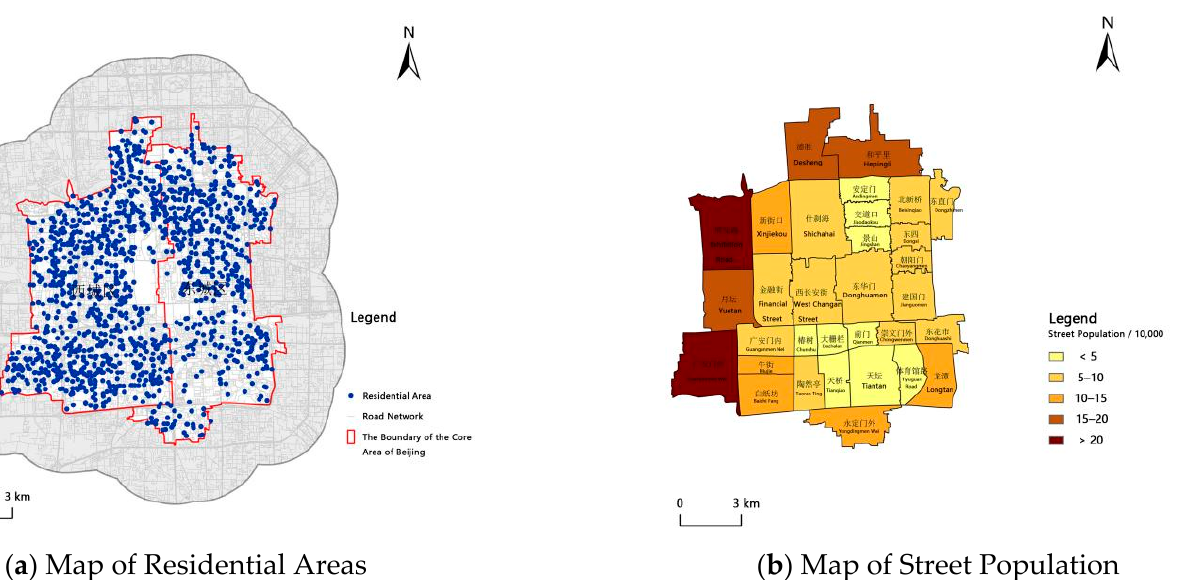
Figure 3. Map of residential areas and street population ( a ) showing the distribution of residential areas in the core area of Beijing; ( b ) showing the distribution of population in the various districts of the core area of Beijing.